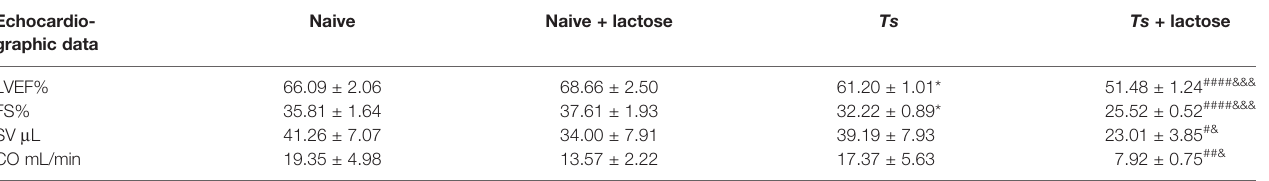
TABLE 2 | The left ventricular systolic function of different groups of mice. Echocardio- graphic data